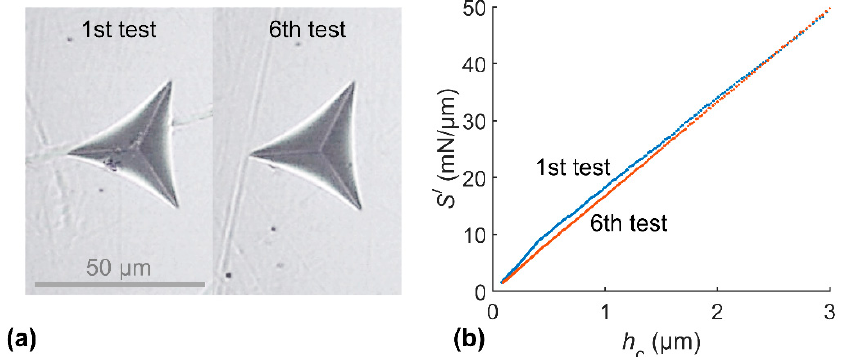
Figure 9. Cleaning of a Berkovich indenter contaminated with Liquitex acrylic gesso by successive indentions into polycarbonate; ( a ) the imprint of the first test (left) showing the paint residue on the sample surface and that of the sixth test (right) showing no signs of contamination, and ( b ) comparison of stiffness versus contact depth for the first and sixth tests.